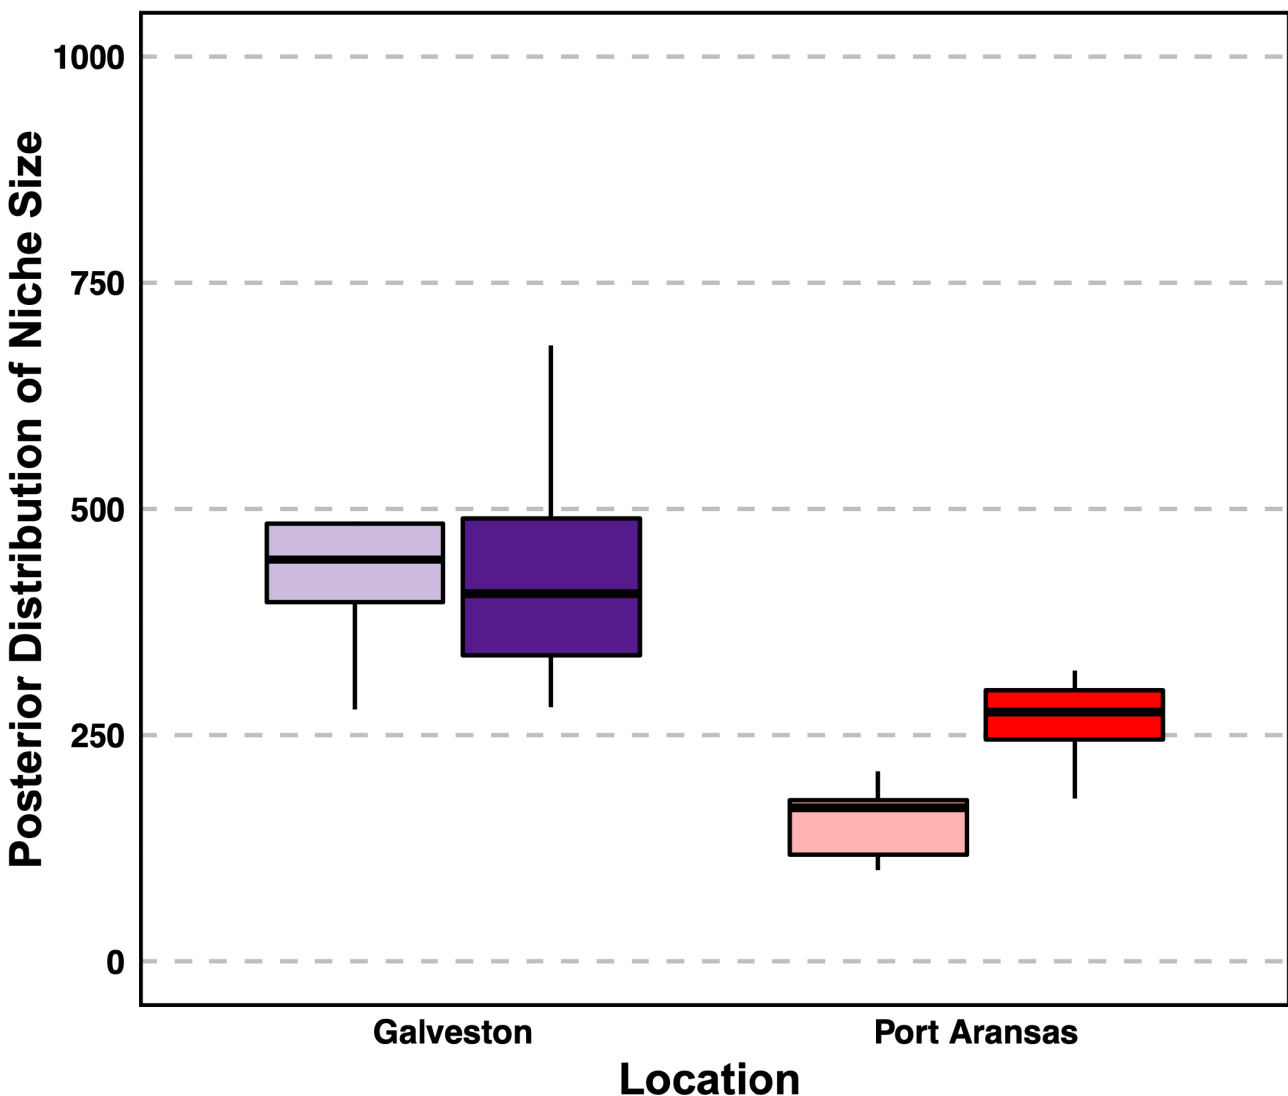
Figure 5. Posterior distribution of niche size. The distribution was determined from the variance matrix of normally distributed niche axes using δ 13 C, δ 15 N, and δ 34 S measured in muscle samples (dark purple and bright red) and liver samples (transparent purple and transparent red).